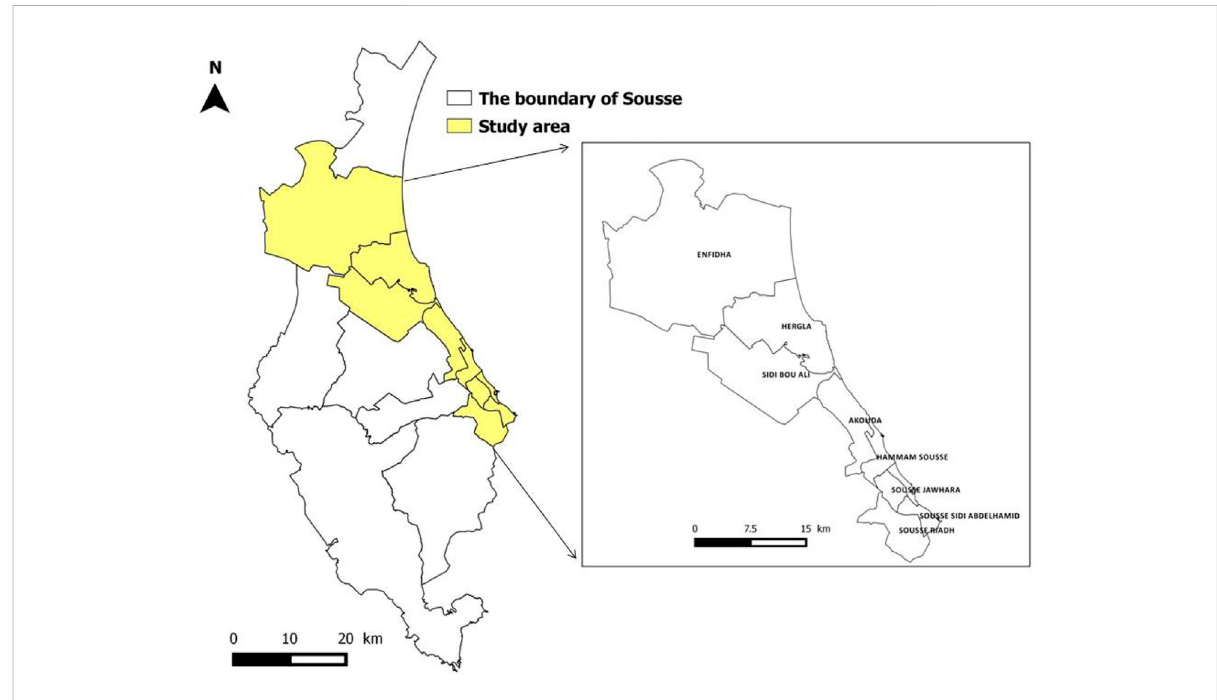
FIGURE 1 Local map of the study